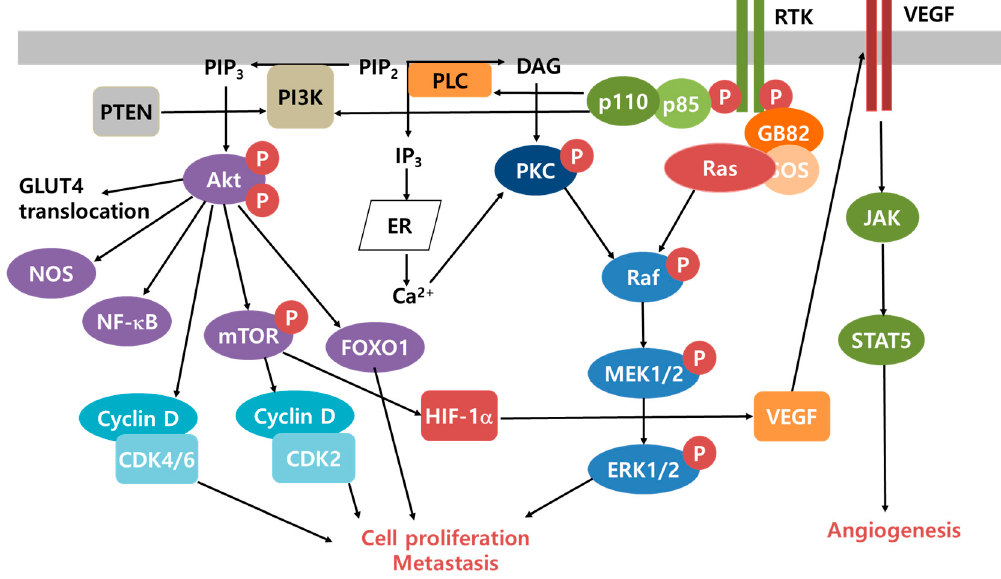
Figure 2. Proliferation, metastasis, and angiogenesis in cancer cells through the Akt, ERK, and STAT signaling cascades. PIP 2 is converted to PIP 3 by PI3K, which activates Akt signaling. Alternatively, PIP 2 can be degraded by PLC into DAG and IP 3 . Remaining in the PM, DAG activates PKC. Next, IP 3 binds to the IP 3 receptor in the ER and triggers Ca 2 + release from the ER, stimulating Ca 2 + -dependent PKC, which activates Raf, MEK, and ERK signaling cascades. After binding with the ligands, RTKs are autophosphorylated and recruit the GRB2 and SOS complex to change inactive Ras-GDP into active Ras-GTP. Activated Ras recruits p110 (a catalytic subunit of PI3K), and phosphorylates PIP 2 , which initiates survival signaling via Akt. Autophosphorylated RTKs can bind to p85 (a regulatory subunit of PI3K), which then attaches to p110 and forms the active complex. mTOR-activated HIF-1a stimulates VEGF, which binds to VEGF ligand and triggers JAK-STAT5 signaling for angiogenesis. Abbreviations: Akt, protein kinase B; CDK, cyclin-dependent kinase; DAG, diacylglycerol; FOXO1, Forkhead family